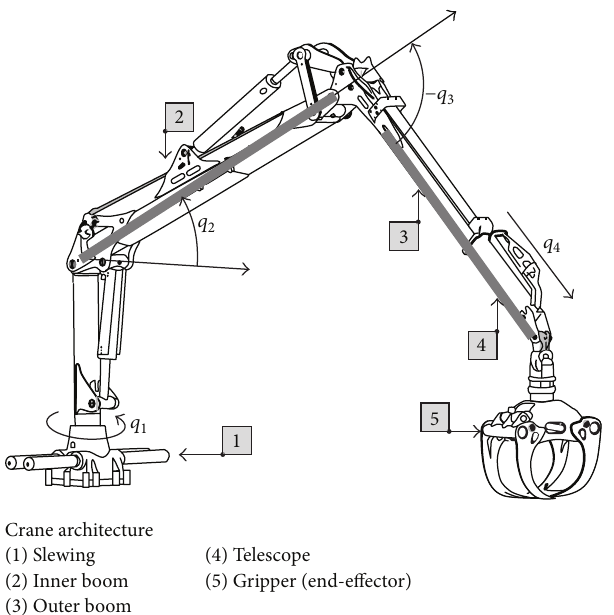
Figure 1: Forwarder crane used for our study. It resembles a kinematically redundant manipulator with four degrees of freedom. The gripper is attached at the boom tip and is used for collecting forest biomaterials.